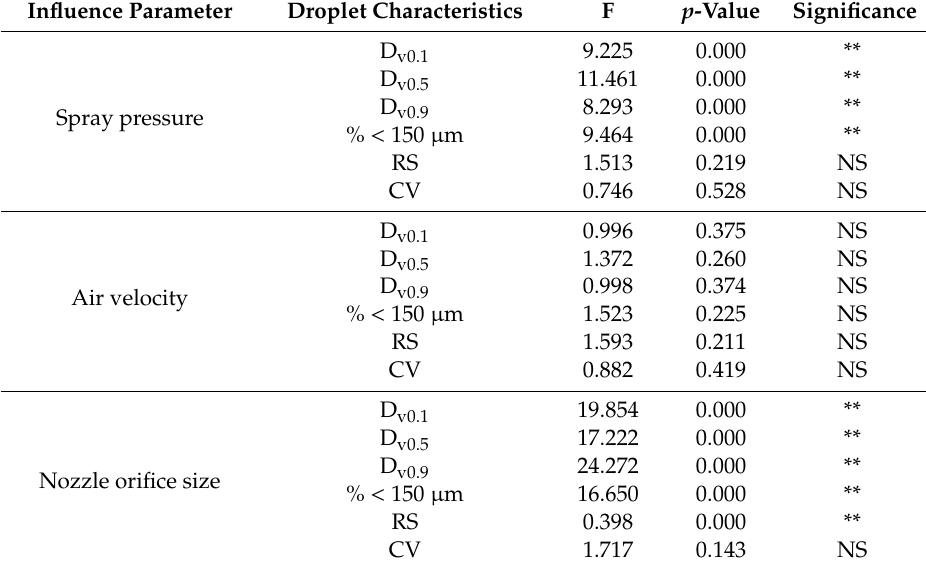
Table 1. The influences of spray pressure, air velocity and nozzle orifice size on the droplet characteristics analysis of variance (ANOVA) using SPSS 25.0. F: Variance of the group mean; p -value: The probability of obtaining the observed results; NS: Not significant, *: Significant, and **: Highly